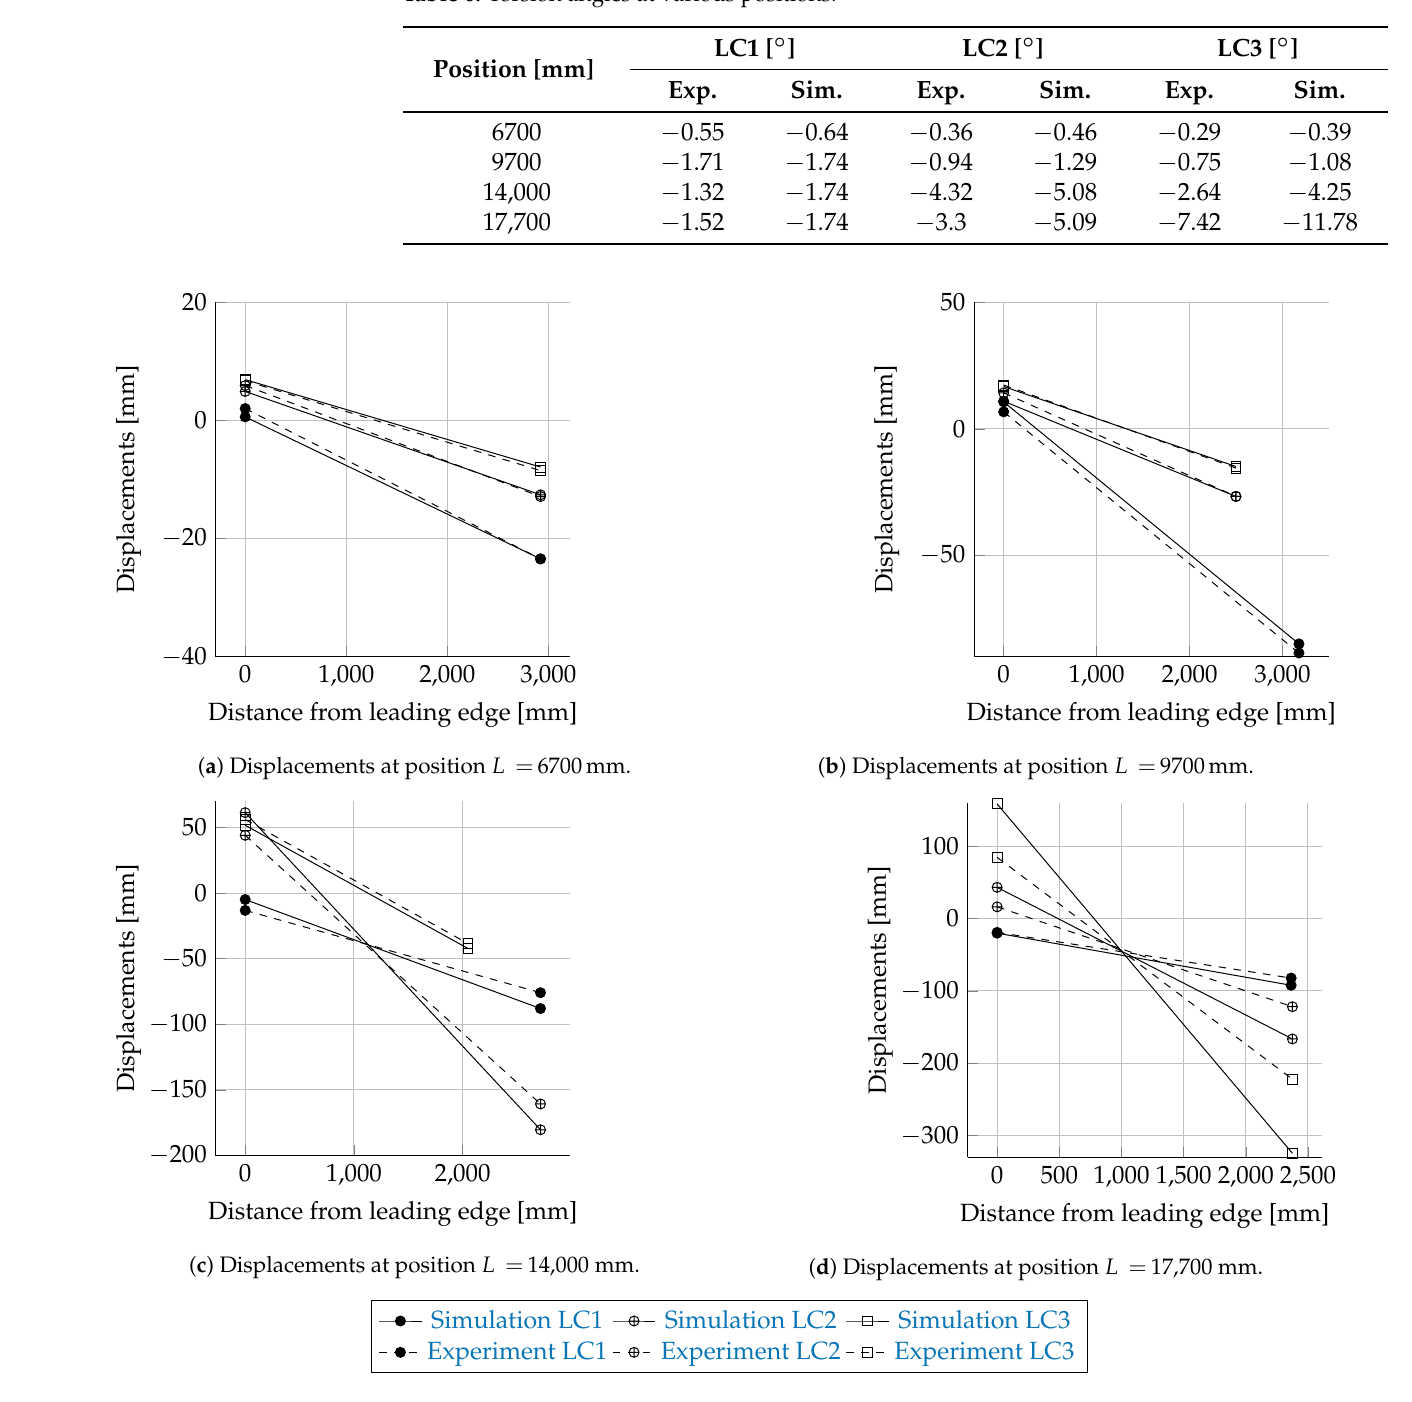
Figure 11. Displacements for all torsion load